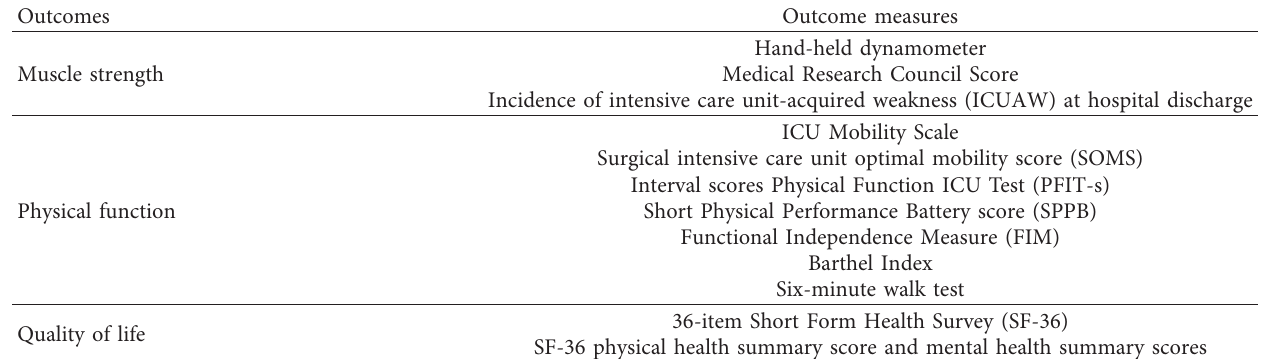
Table 3: Outcome measures for assessing the effectiveness of early mobilization in the intensive care unit.